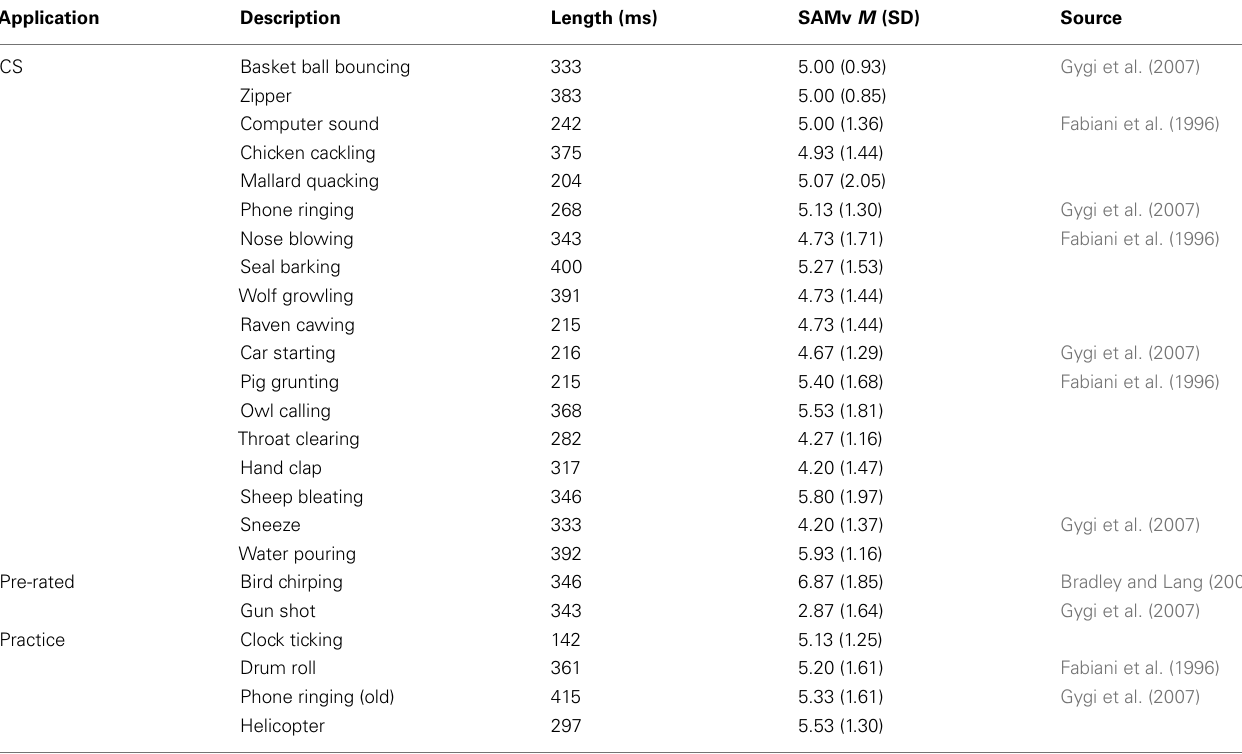
TableA1 | Description, length, mean and SD of SAMv rating and source of the sounds used as CS in the evaluative conditioning phase and as primes in the affective priming